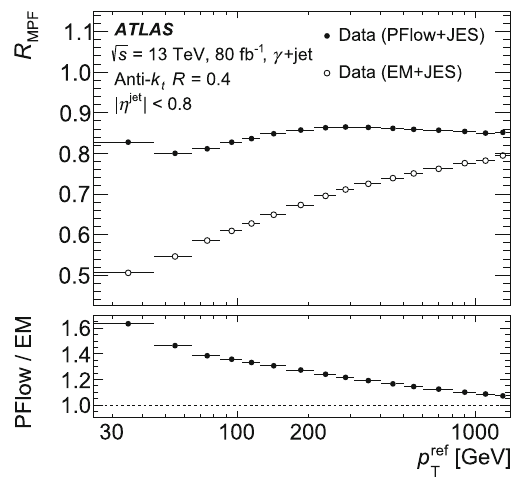
Fig. 15 Average jet response as a function of reference p T for γ +jet eventscalculatedusingtheMPFtechniquein2015–2017data.Thesolid points correspond to PFlow jets while the hollow points correspond to EMtopo jets. The ratio of PFlow response to EMtopo response is shown in the bottom